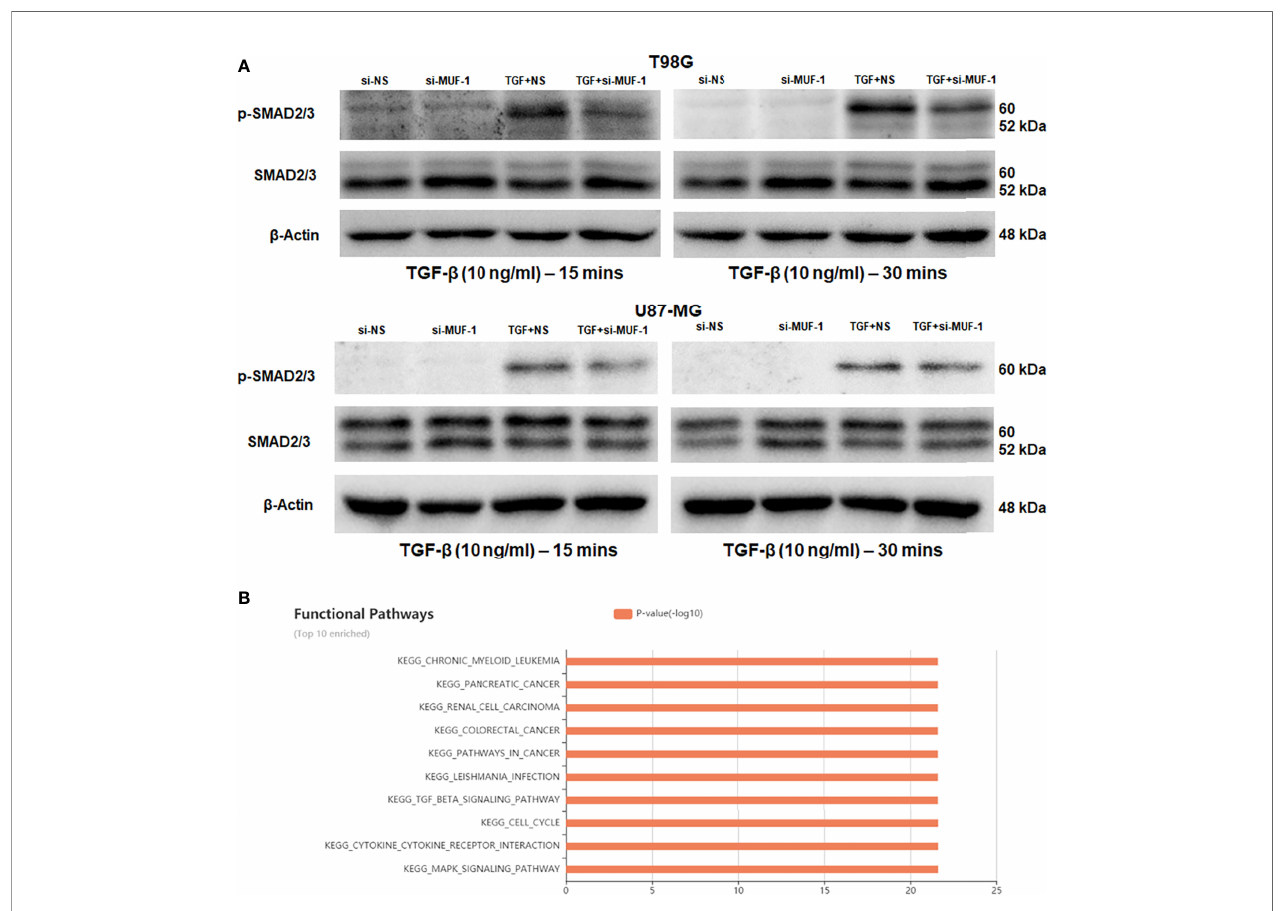
FIGURE 5 | LncRNA-MUF regulates TGF- b signaling. (A) LncRNA-MUF knockdown impairs phosphorylation of the smad2/3 complex. Western blot analysis of psmad2/3 and total smad2/3 levels in T98G and U87-MG cells treated with 10 ng/ml TGF- b 1 (15 and 30 min), 48 h after lncRNA-MUF knockdown with si-MUF-1. A representative blot is shown from three independent experiments with similar results. Blots were reprobed for b -actin to establish equivalent loading. (B) Top 10 enriched signaling pathways regulated by lncRNA-MUF identi fi ed from the lncACTdb